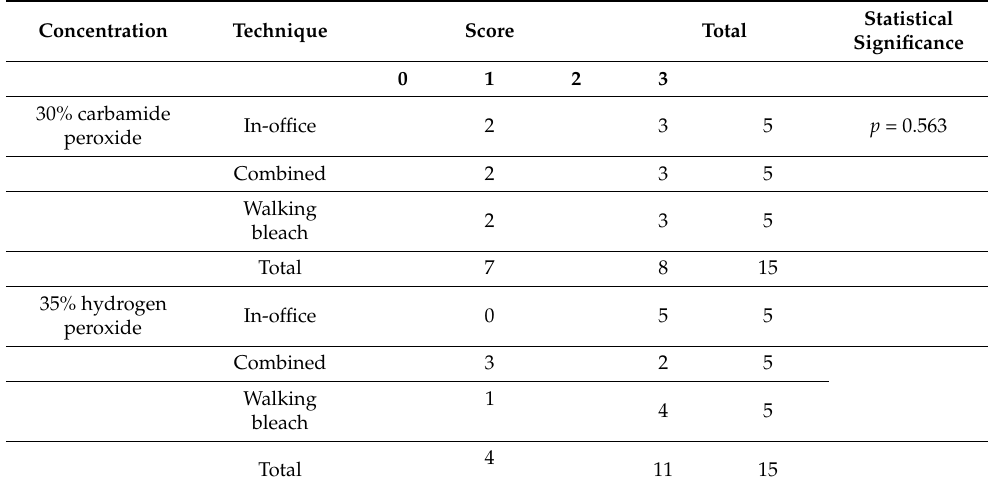
Table 6. Bleaching success depending on the bleaching agent and